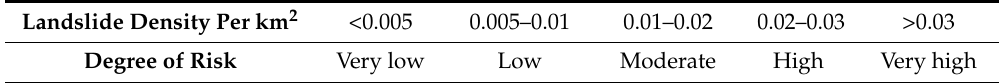
Table 2. The classified landslide density categories.